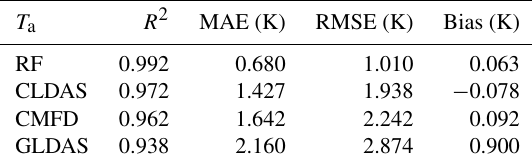
Table 6. Evaluation results of four datasets in